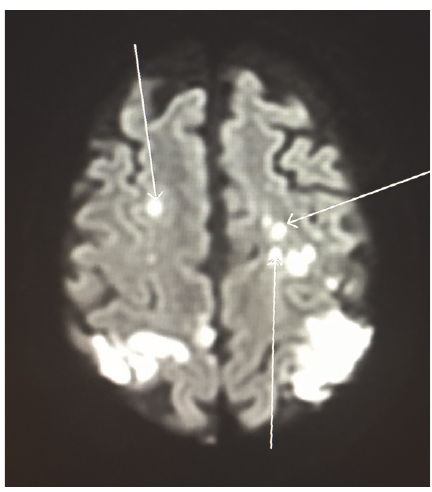
Figure 1: Brain MRI showing multiple septic emboli.